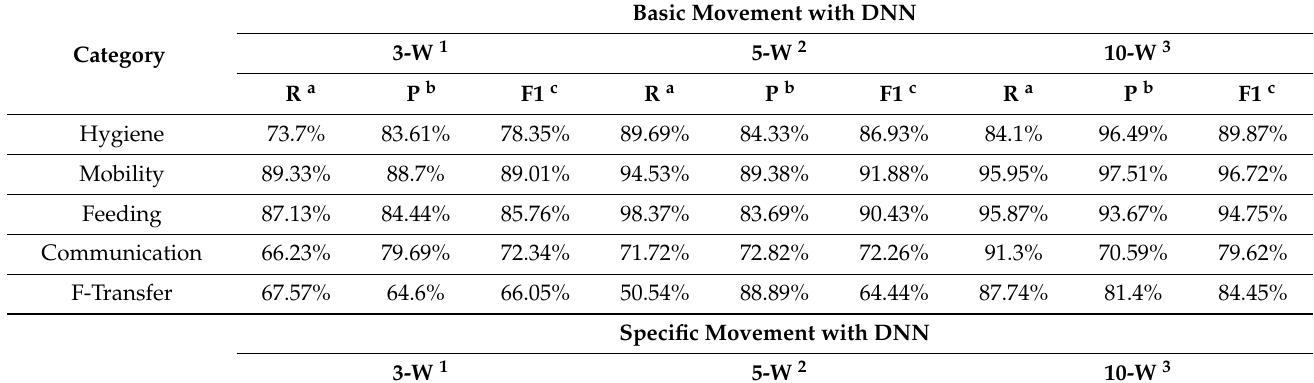
Table 2. Best result of basic and specific movement of wrist-worn dataset 3, 5, 10-s window using DNN